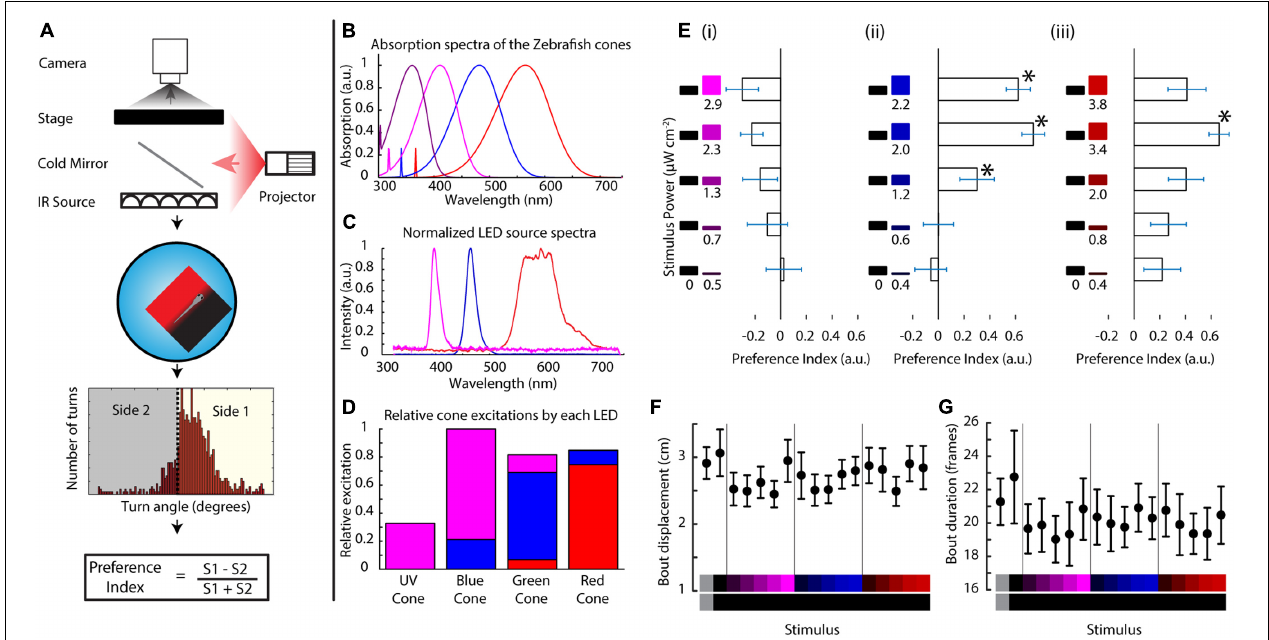
FIGURE 1 | Zebrafish larvae perform phototaxis and UV avoidance in a closed loop paradigm. (A) Closed loop apparatus used in this manuscript. The fish is monitored in real time at ∼ 100 fps using a camera. The larva swims freely in a petri dish arena illuminated with infrared light. As the animal swims, its movements are tracked in real time and stimuli are projected from the bottom, aligned to the animal. After each experiment, the larval movement is segmented into individual turn events that are condensed into a preference index reflecting the stimulus choice of the animal. (B) Modeled absorption spectra of the larval zebrafish cone pigments, including the beta band of absorption. (C) Emission spectra of the LEDs used to project stimuli in this manuscript. (D) Theoretical relative excitation each LED elicits on each cone. The colors correspond to the LED colors in (C) . As mentioned, all cones are excited to an extent. (E) Larval turning direction preference indices for UV, blue and red stimuli against darkness. The stimuli are listed at the left side of each plot and preference index is expressed as the length of the horizontal bars (bars are mean ± SEM, N = 19 larvae from different clutches. Stars represent p -value < 0.05 in a paired bootstrap test comparing the lowest power level to the others). (F,G) average total displacement per bout (F) and duration of each bout (G) for each of the stimuli used above. Stimuli are indicated at the bottom with the color on each side represented vertically (points are mean ± SEM, fish are same as